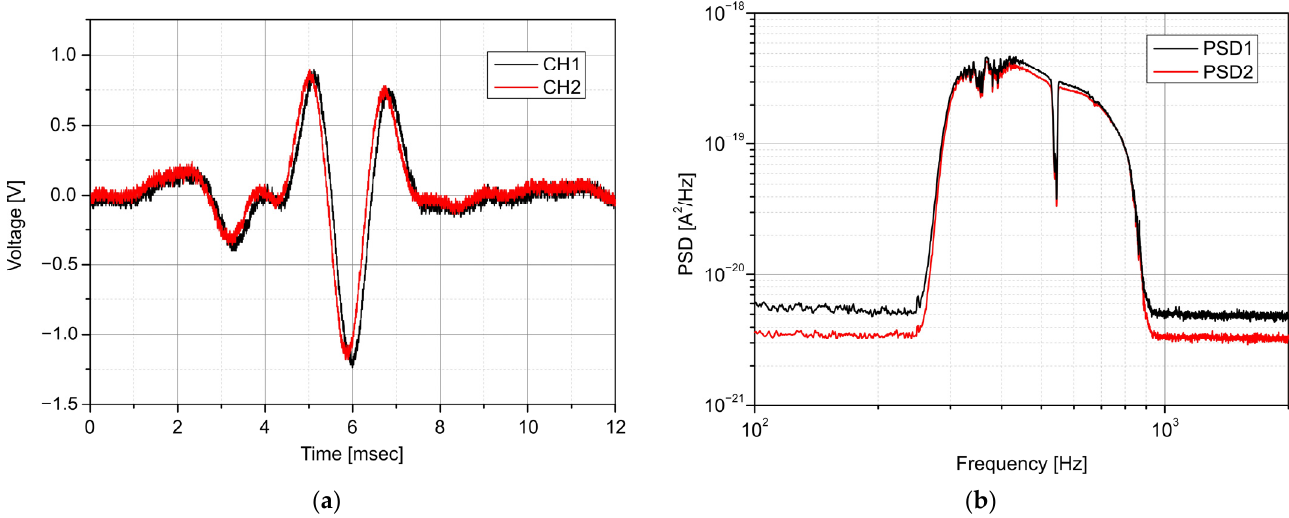
Figure 6. The interferograms registered separately by CH1 channel and CH2 channel ( a ) and their PSD ( b ) without any absorbing sample placed in FTIR optical